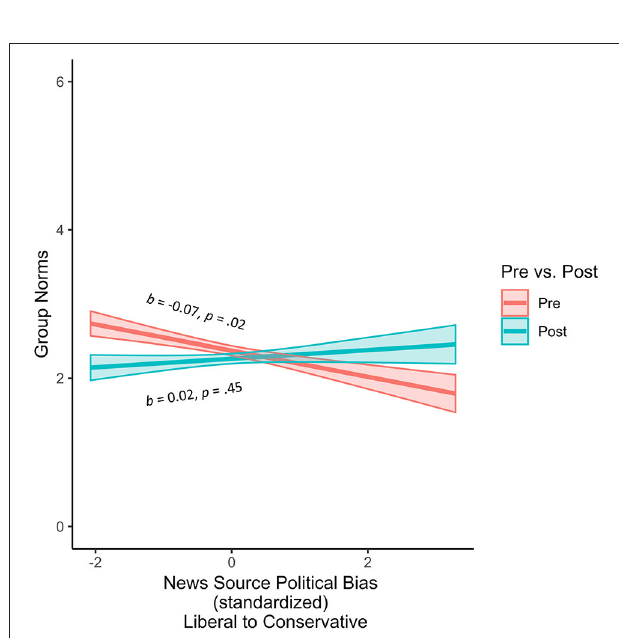
FIGURE 3 | Group norms as a function of time x news source. F (1, 562) = 6.15, p = 0.014, 95% CI[0.01, 0.08], PRE = 0.01; Scale bands represent 95% confidence